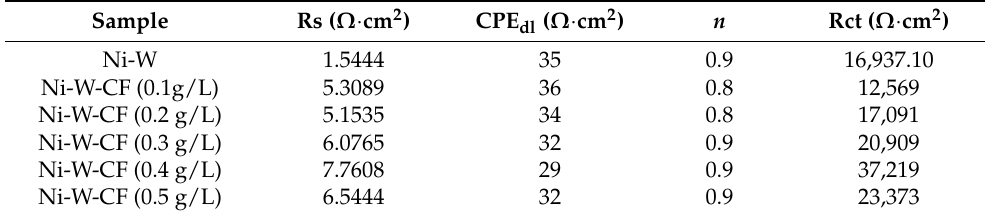
Figure 7. Equivalent circuit model for EIS fitting. Table 3. Fitting results of EIS of coatings.